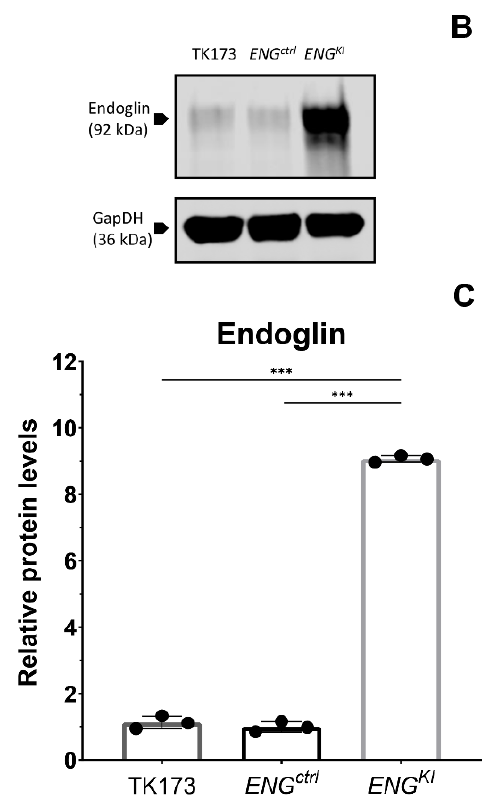
Figure 3. ENG mRNA and endoglin protein levels in TK173 human kidney fibroblasts lentivirally transduced with an endoglin and a control construct. ( A ) ENG mRNA levels measured using qPCR in non-transduced TK173 cells and TK173 cells transduced with an empty vector control ( ENG ctrl ) or with a vector containing a full length ENG RNA sequence ( ENG K I ). Data are expressed relative to ENG ctrl . Results were corrected for the housekeeping gene HPRT . ( B ) Endoglin protein levels in transduced ENG K I and ENG ctrl and non-transduced TK173 cells were determined by Western blotting. The figure depicts a representative Western blot. ( C ) Quantification of the results obtained from the Western blots. Protein levels were corrected for the loading control GAPDH. Endoglin protein is expressed relative to ENG ctrl . Data are presented as means ± SD from three independent experiments. *** p < 0.001 (Student’s t -test derived from a one-way ANOVA after log-transformation of the outcome variable).